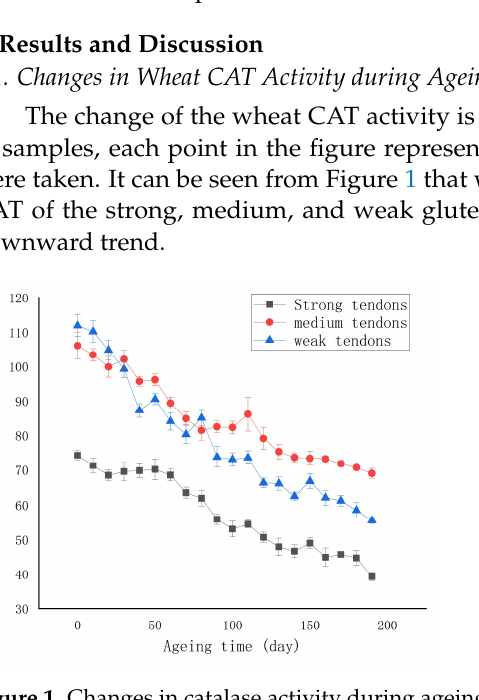
Figure 1. Changes in catalase activity during ageing.